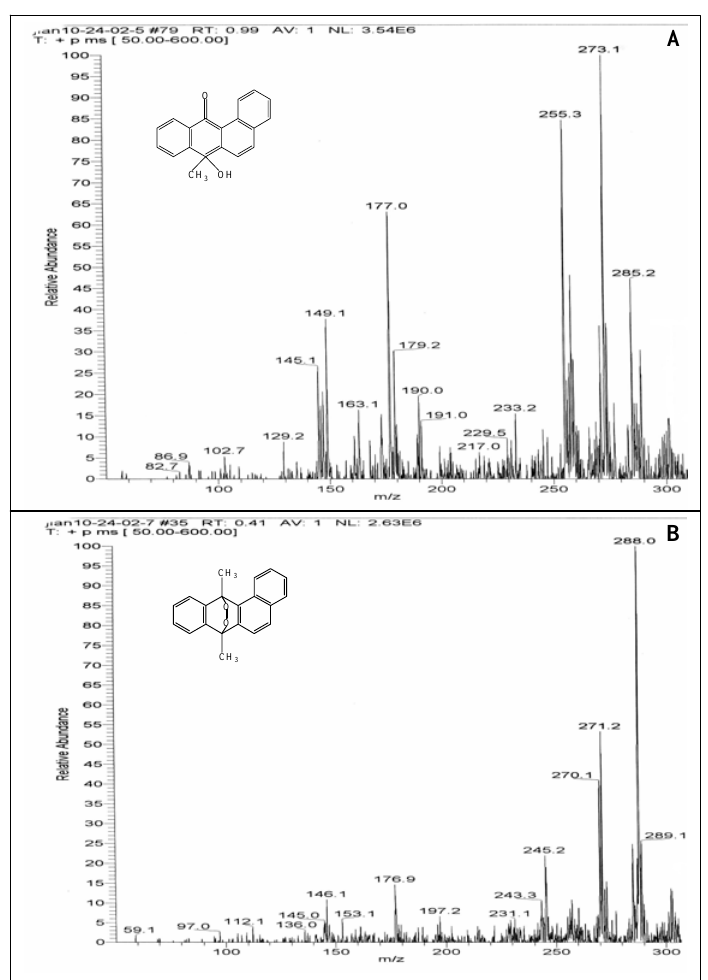
Figure 3: Mass spectrum profiles of purified P5 (A) and P8 (B) of DMBA